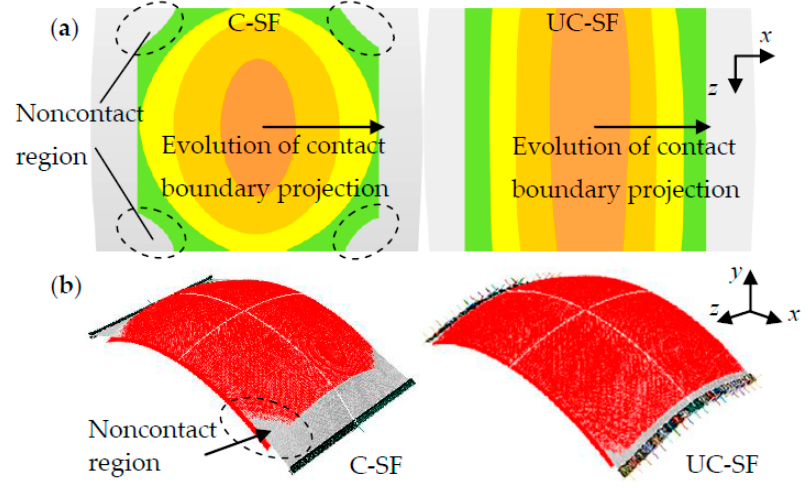
Figure 8. Contact state for spherical part. ( a ) Contact state evolution; ( b ) final contact state.